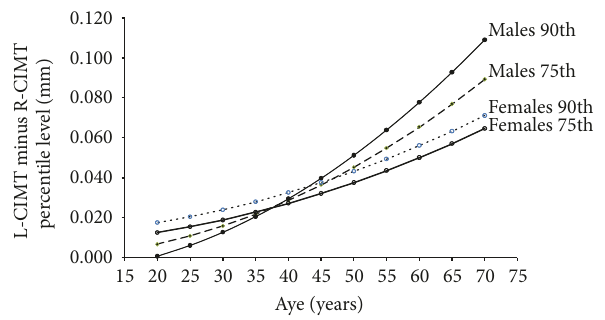
Figure 6: Percentile differences (75th and 90th) between L-CIMT andR-CIMTaccordingtoageandsex.L:left.R:right.CIMT:carotid intima media thickness.